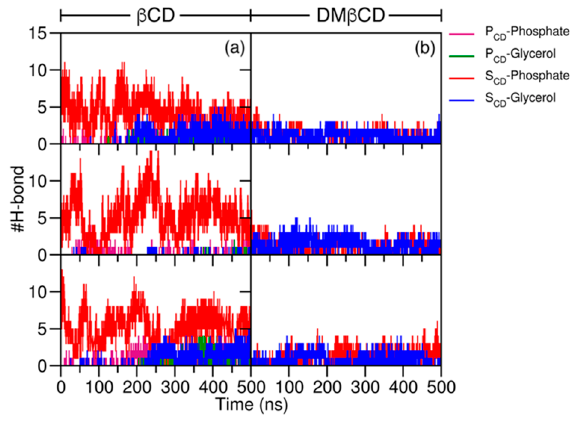
Figure 5. The number of H ‐ bonds between the primary (P CD ) or secondary (S CD ) rim of ( a )  CD, ( b ) DM  CD, and lipid head groups (phosphate and glycerol esters). ( b ) DM β CD, and lipid head groups (phosphate and glycerol